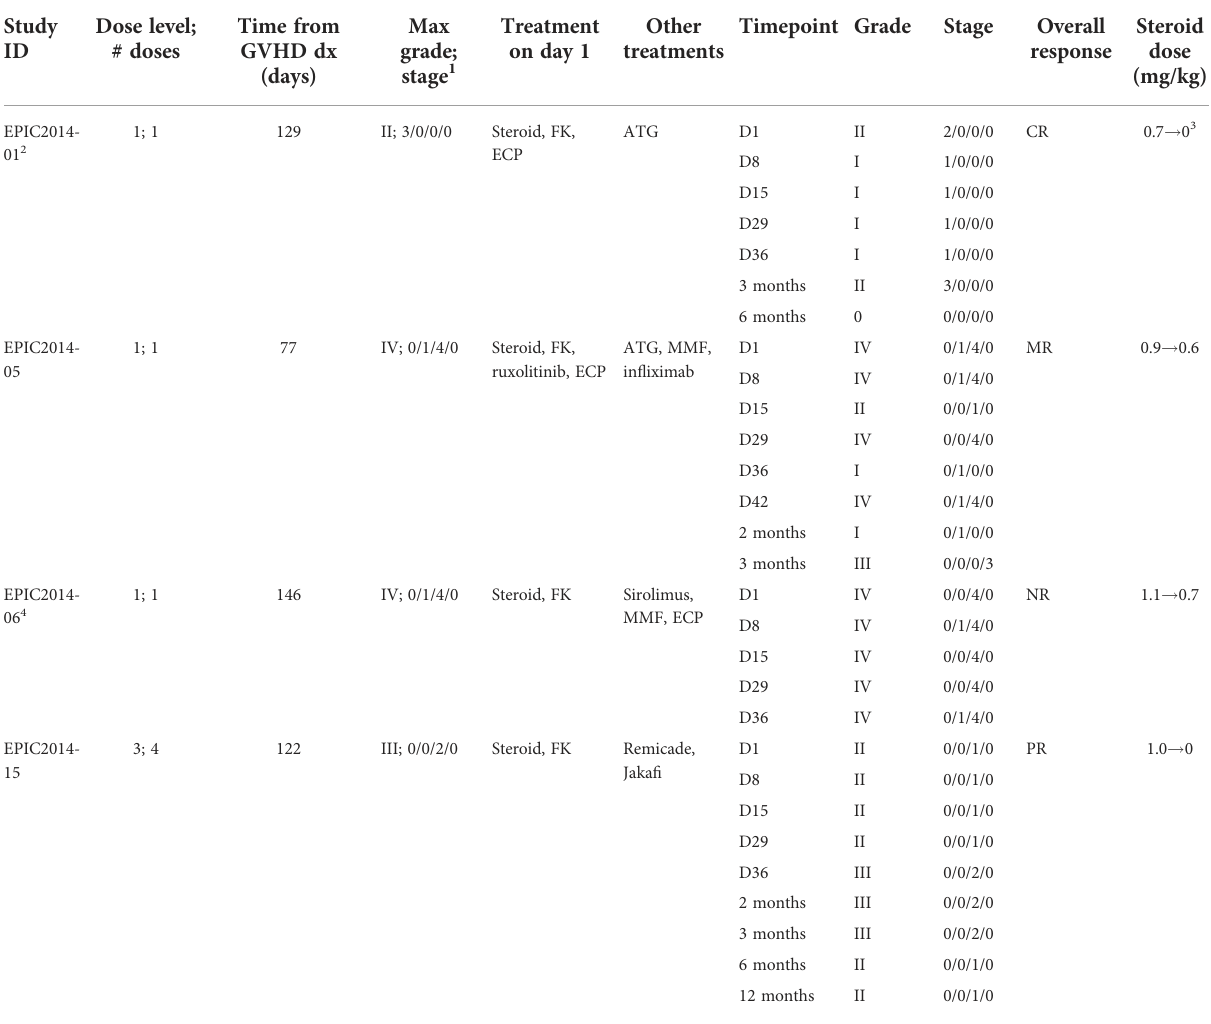
TABLE 2 Acute GVHD characteristics and response following autologous MSC